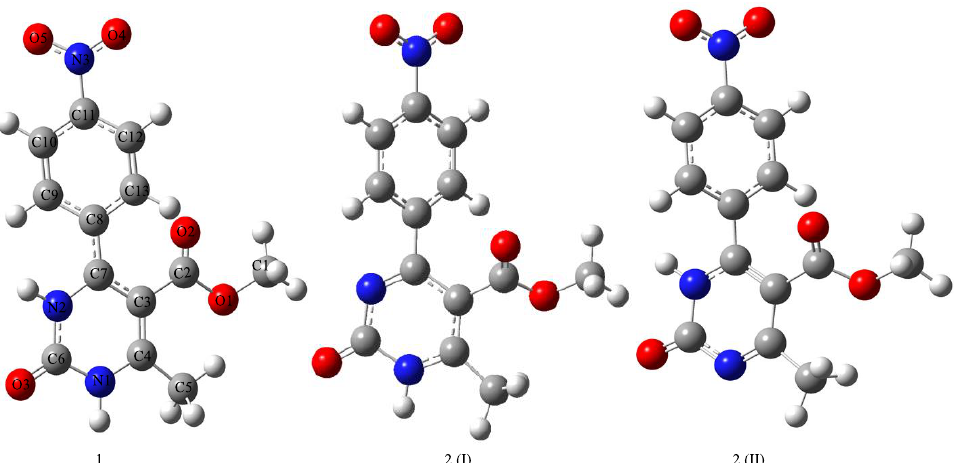
Figure 7. Optimized structure of the investigated compounds. Table 5. Geometric parameters of the compounds calculated at the B3LYP/6-31+G (d, p) level. Assignments Bond Lengths(Å )